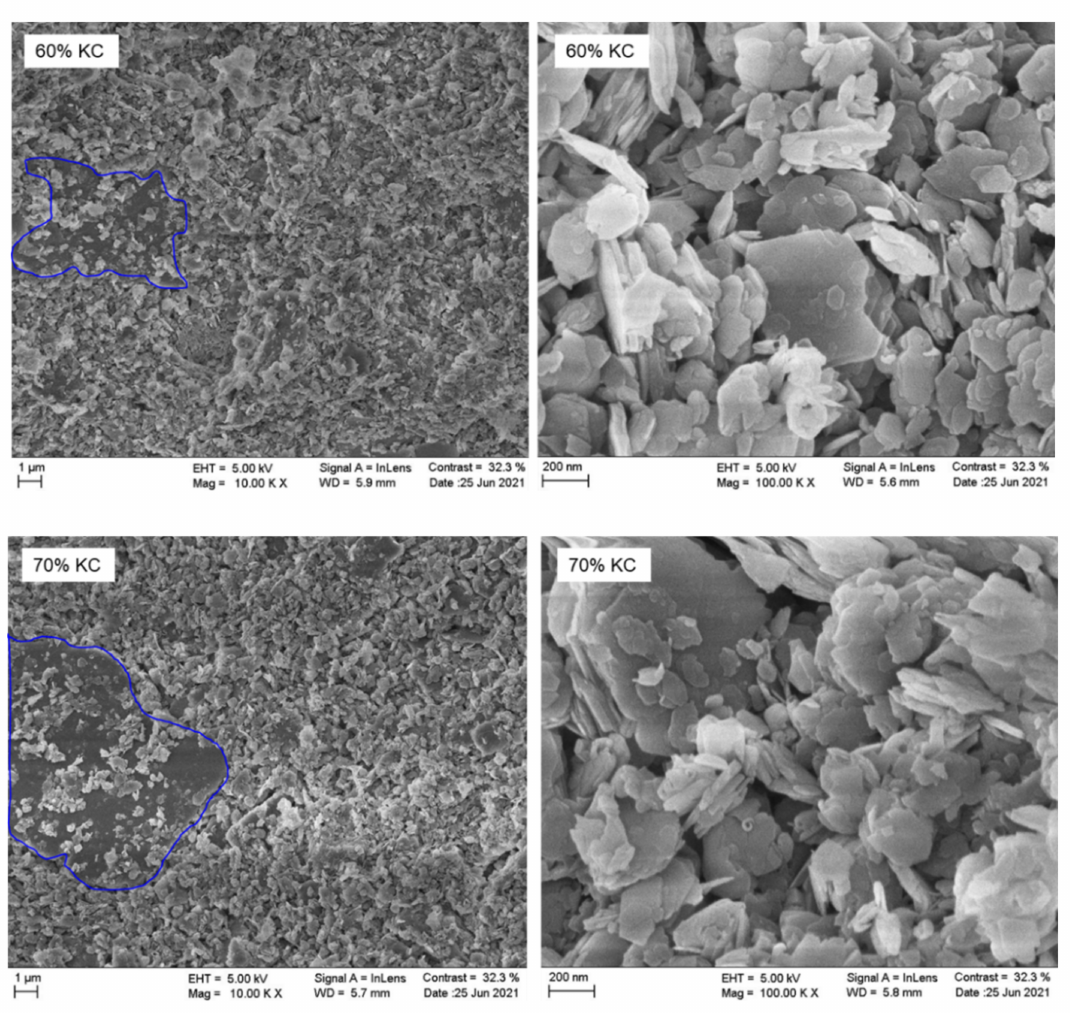
Figure 11. Particle shape in all mixtures with 10,000 × and 100,000 × magnification by